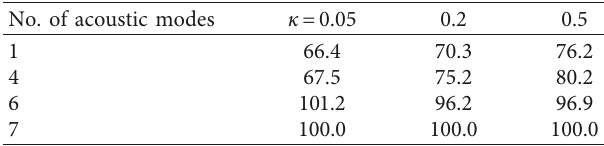
Table 3: (3,1) mode peak vibration amplitude convergence for various excitation magnitudes (3 symmetric structural modes, ζ � 0.02).